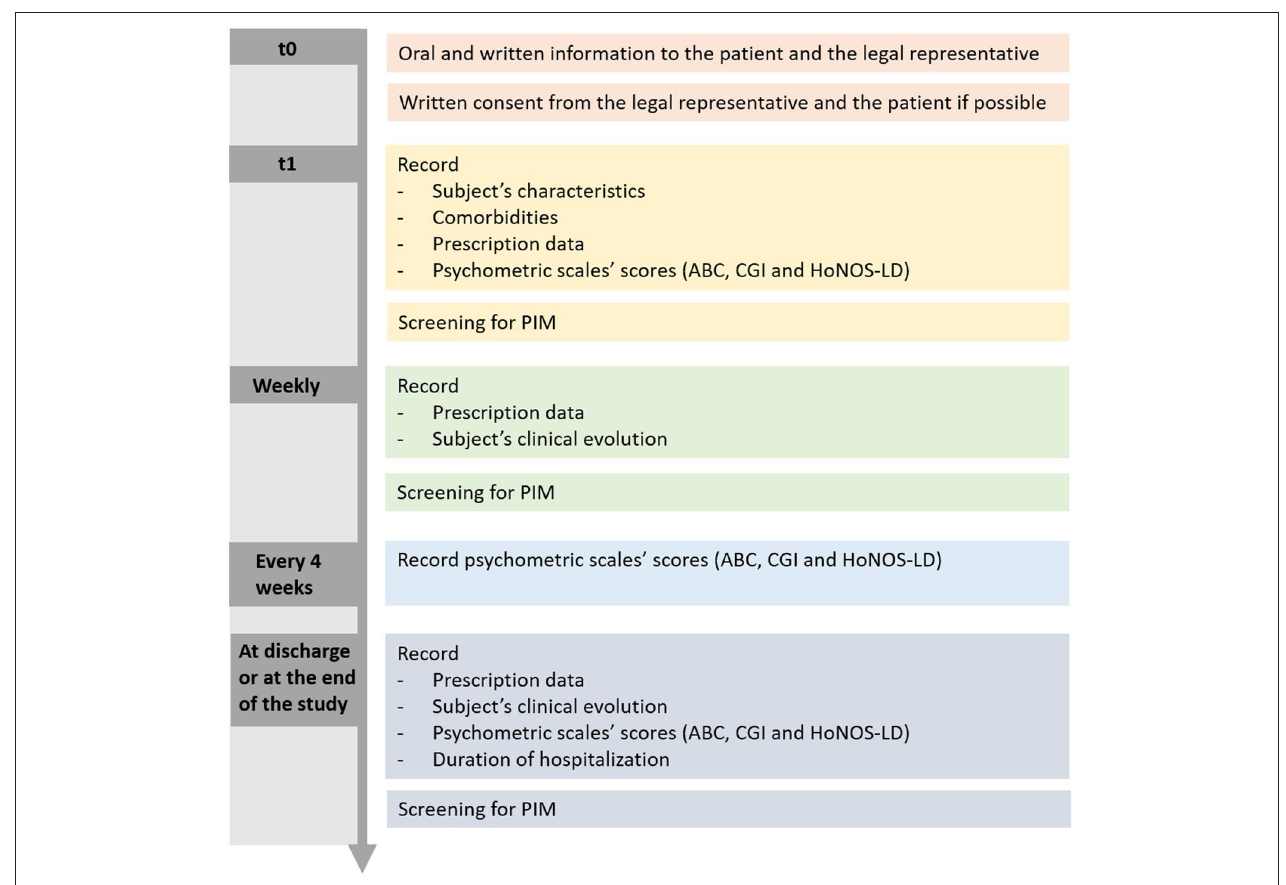
FIGURE 1 | Typical schedule of assessment for a